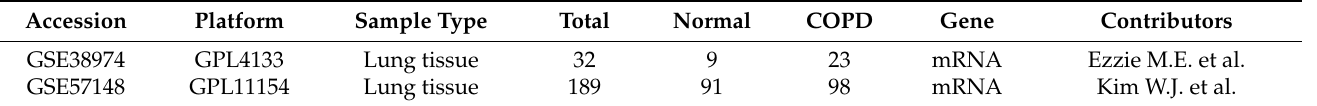
Table 1. Characteristics of the datasets used in this